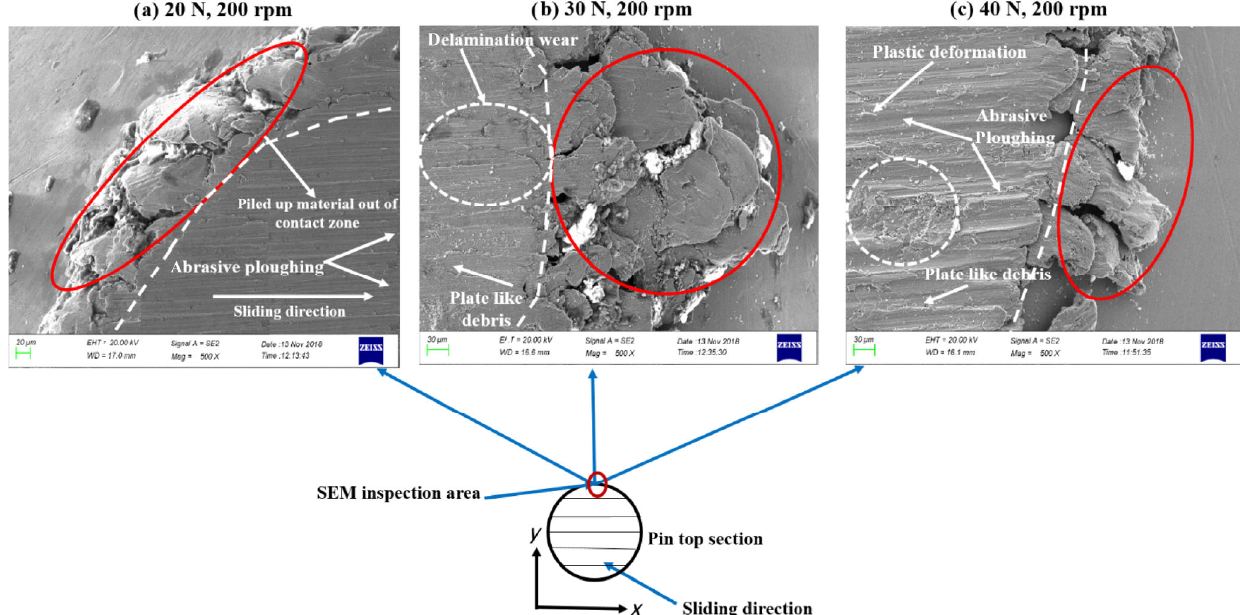
Fig. 25 SEM micrographs of AISI 304 steel for different normal loads under the speed of 200 rpm: (a) 20 N, (b) 30 N, and (c) 40